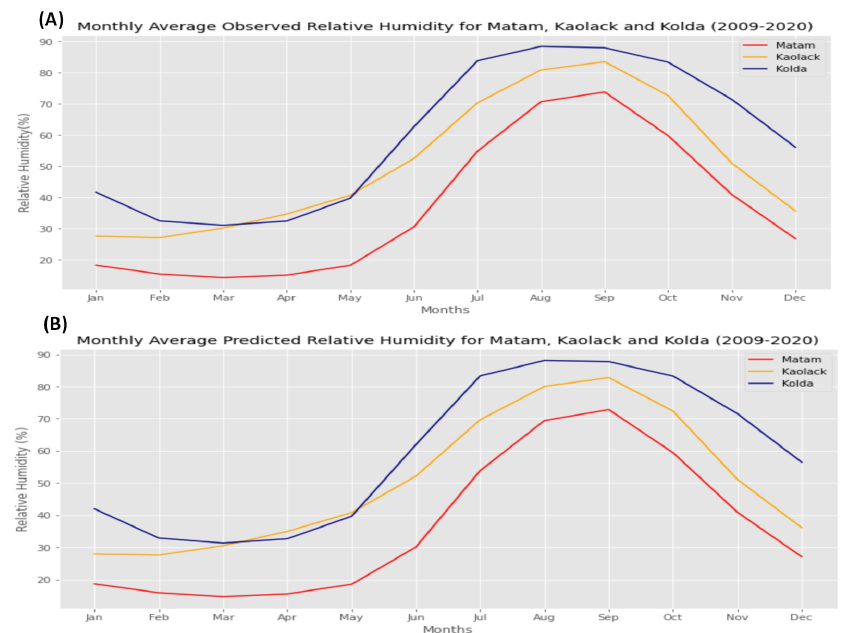
Figure 24. Monthly Average Observed and Forecasted Relative Humidity for Matam, Kaolack and Kolda